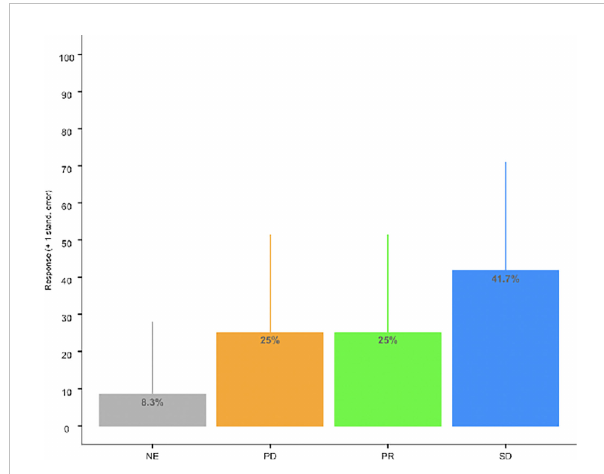
FIGURE 1 Bar Chart of ORR. Disease Control Rate [DCR) (SD + PR: 66.7% (95% CI: 34.9, 90.1)].